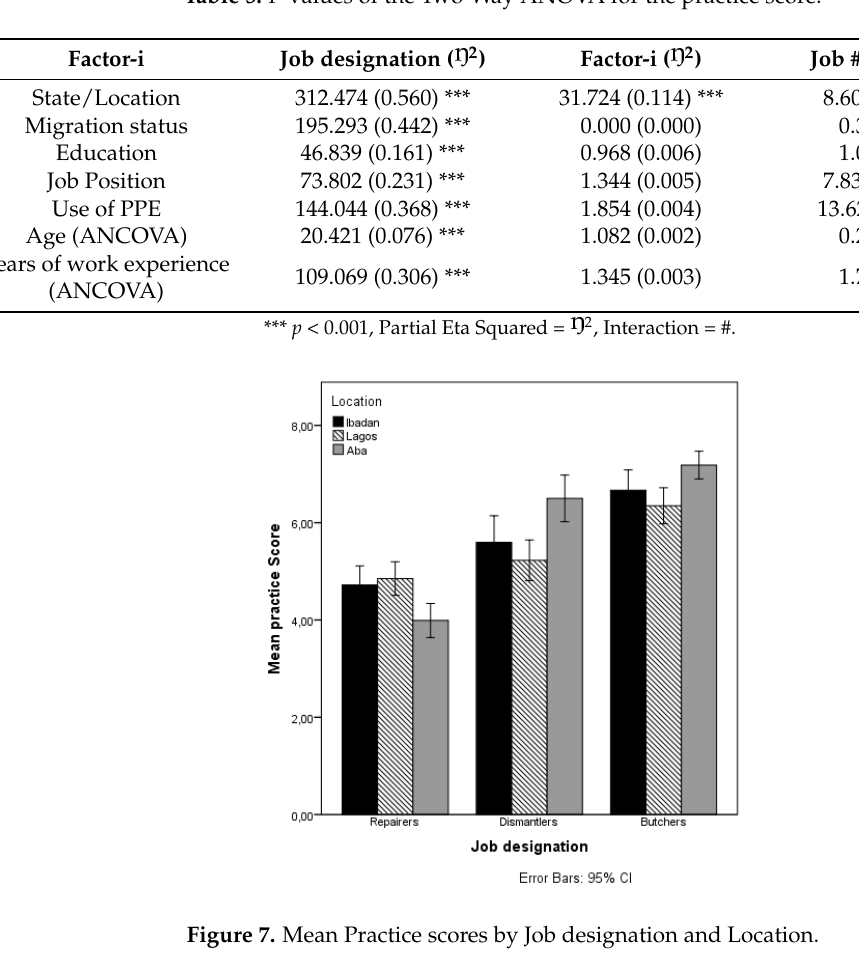
Table 5. F -values of the Two-Way ANOVA for the practice score.